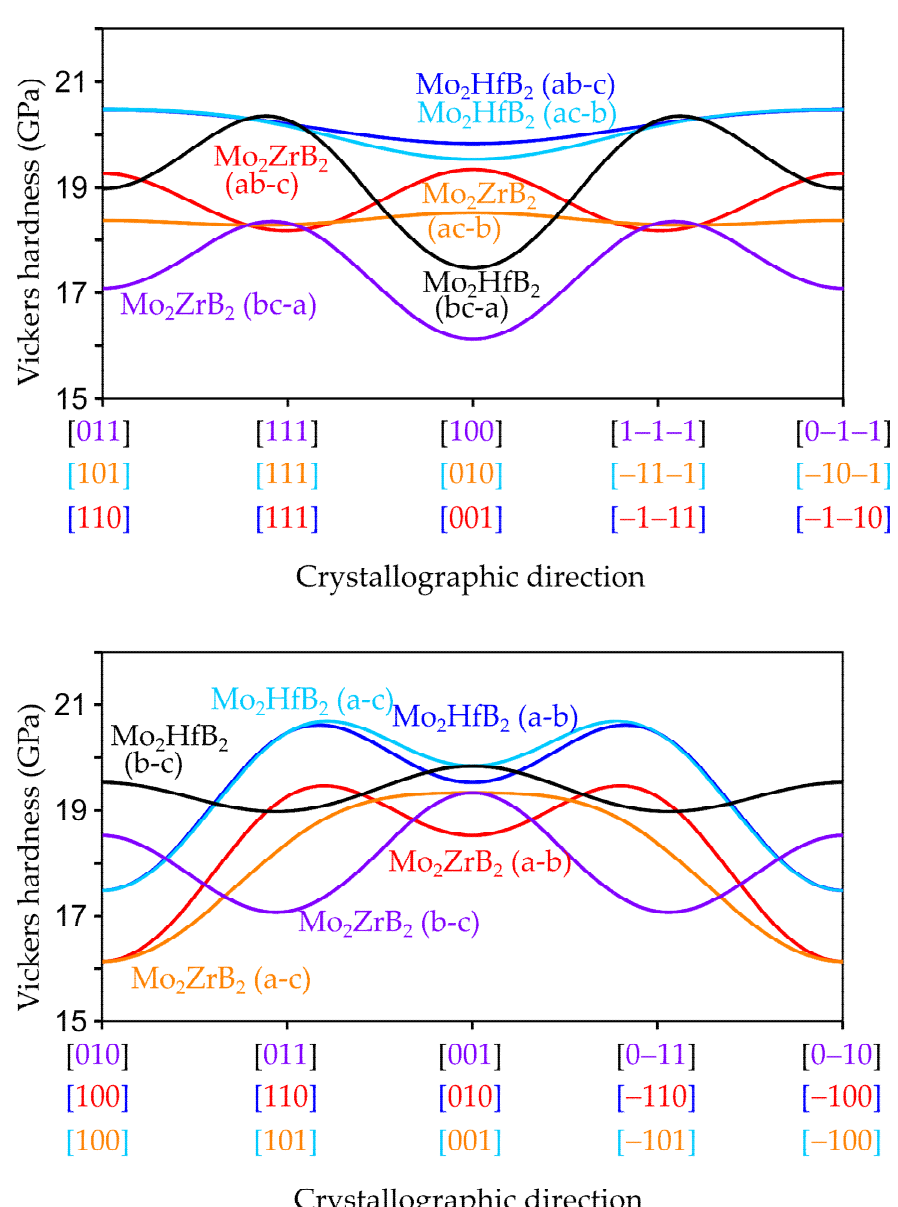
Figure 7. Anisotropic Vickers hardness in the a - b , a - c and b - c -plane ( lower part ) and the ab - c , ac - b and bc - a -plane ( upper part ) of Mo 2 ZrB 2 (red, orange and purple) and Mo 2 HfB 2 (blue, cyan and black), respectively, both with the AlMn 2 B 2 -type